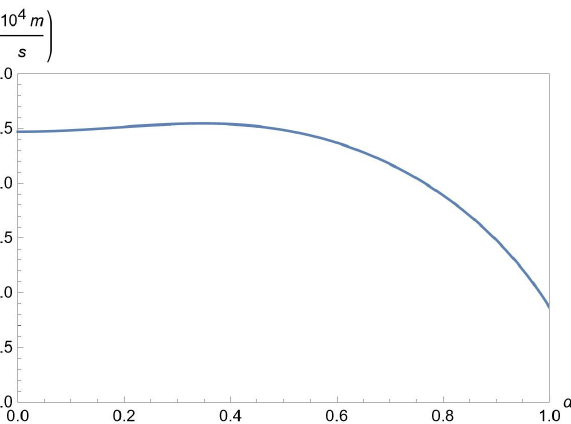
Figure 7. Plot of the sound velocity c ≡ c 1 versus α for chosen gap ∆ = ¯ hv F / a , interlayer separations D = 25 nm at fixed concentrations n A = 50 × 10 11 cm − 2 and n B = 50 × 10 11 cm − 2 of A and B excitons,